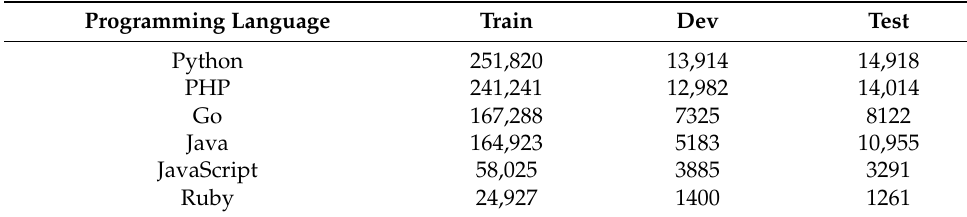
Table 1. CodeSearchNet data set.